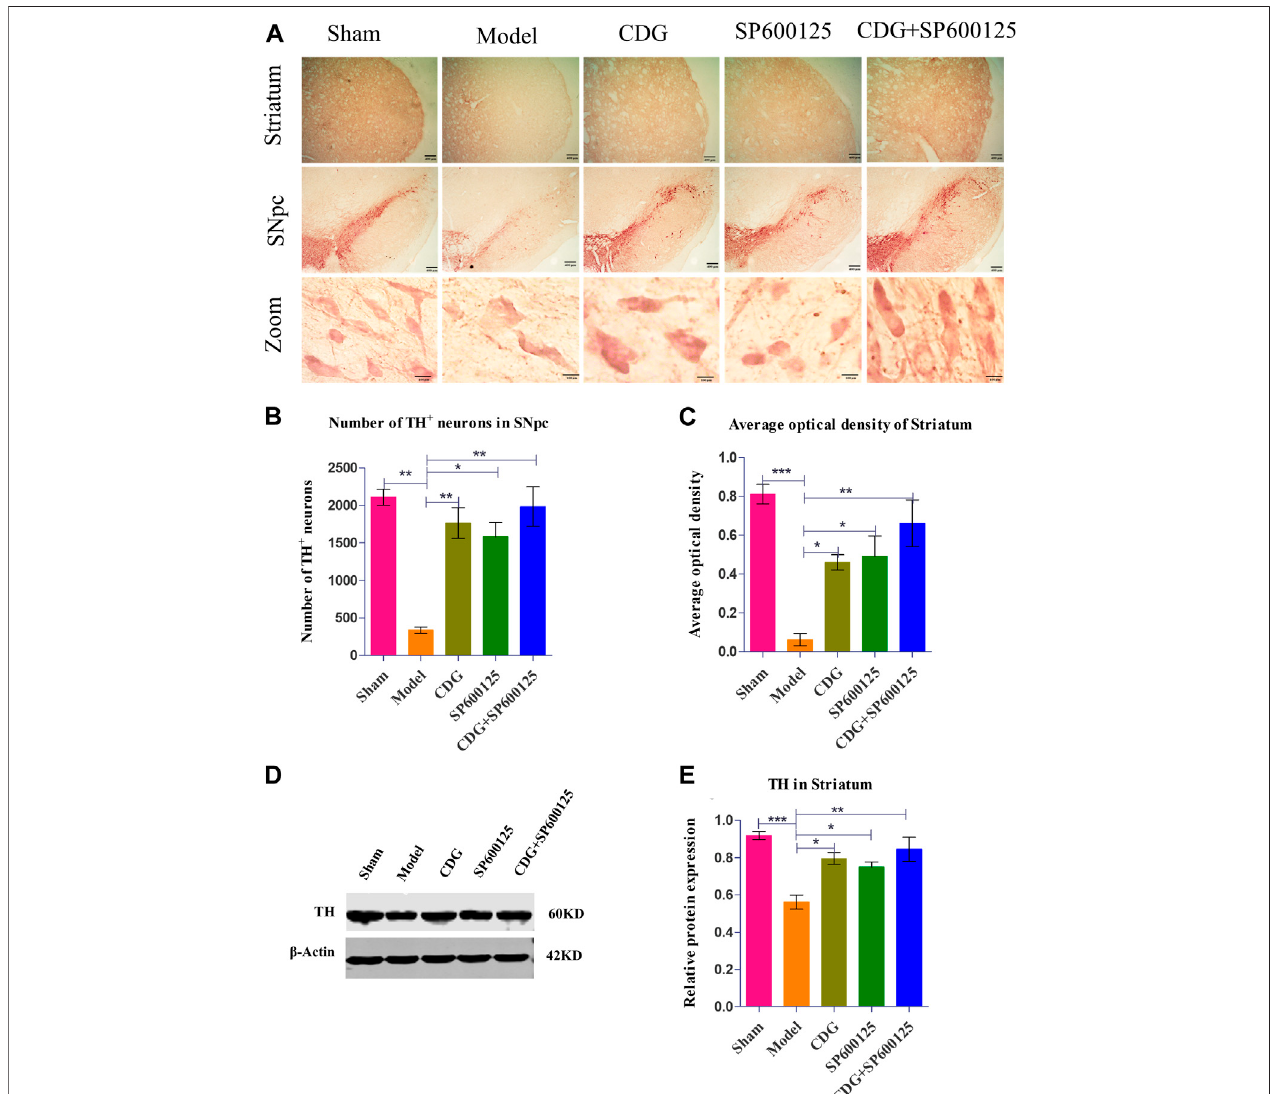
FIGURE6| 6-OGDA-inducedlossofDAneuronsinthenigrostriatalpathwayoftheratbrain. (A) DABstainingofTHonmidbrainsectionsineachgroup(Scalebar: 400 μ m; Zoomed Scale bar: 100 μ m). (B) Stereological counts of TH-positive cells of the SNpc at 6 weeks after 6-OFDA intoxication. (C) Average optical density of striatum in each group. (D) The expression level of TH proteins was detected with Western Blot in the striatum. (E) The expression level of TH protein in each group. GAPDH served as control. Statistical analysis was performed with One-Way NOVA or Two-Way NOVA, n (cid:1) 3. Signi fi cant differences were indicated by * p < 0.05, ** p < 0.01, *** p <